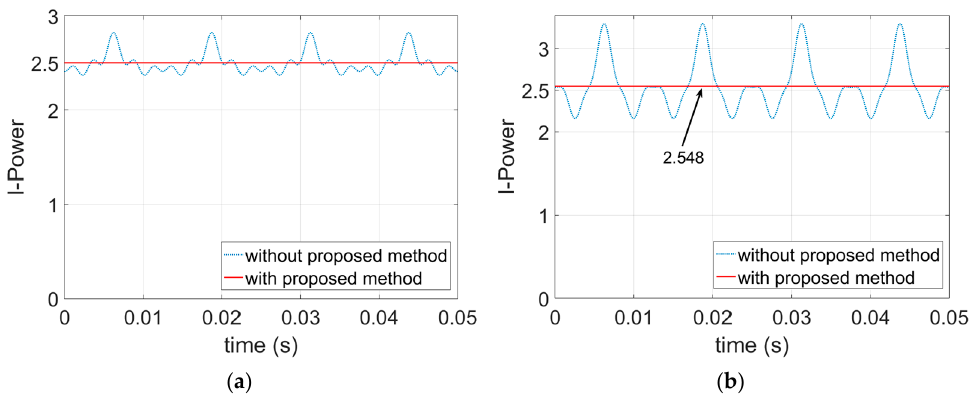
Figure 4. I-power graphs for the single-phase OCFT condition currents: ( a ) Fundamental; ( b ) fundamental plus third harmonic.